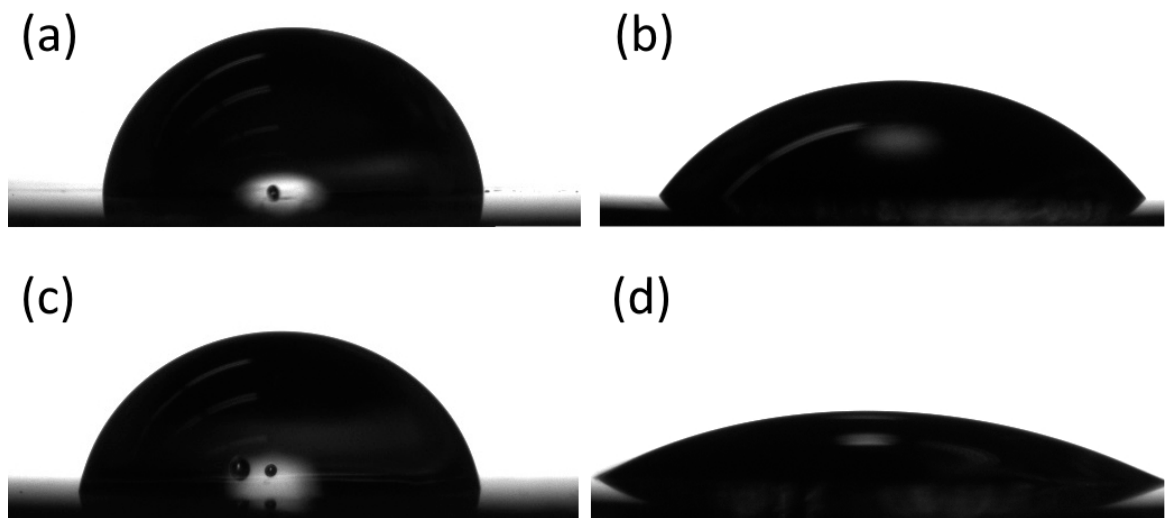
Figure 3. Example images of contact angle measurements for ( a ) bare stainless steel, ( b ) cleaned stainless steel, ( c ) MEG- TFA-modified stainless steel, and ( d ) MEG-OH-coated stainless steel.